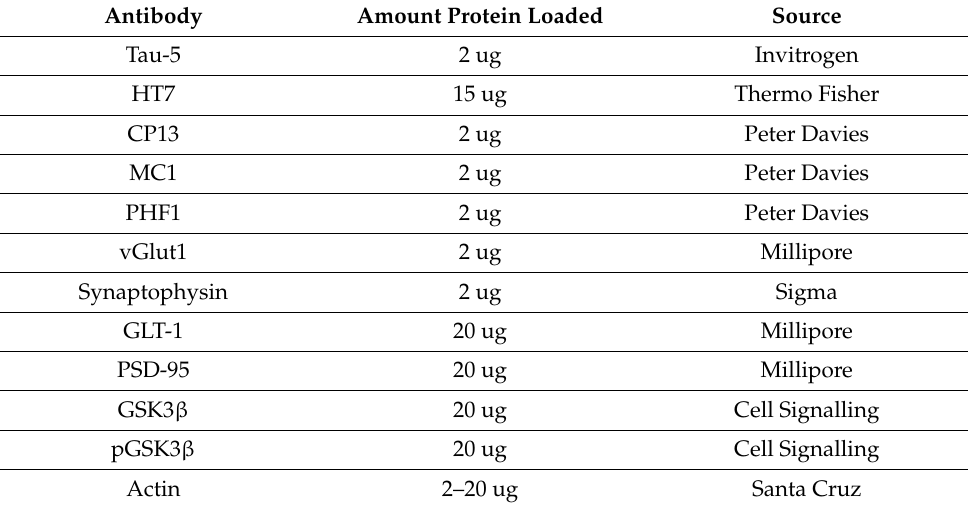
Table 1. List of